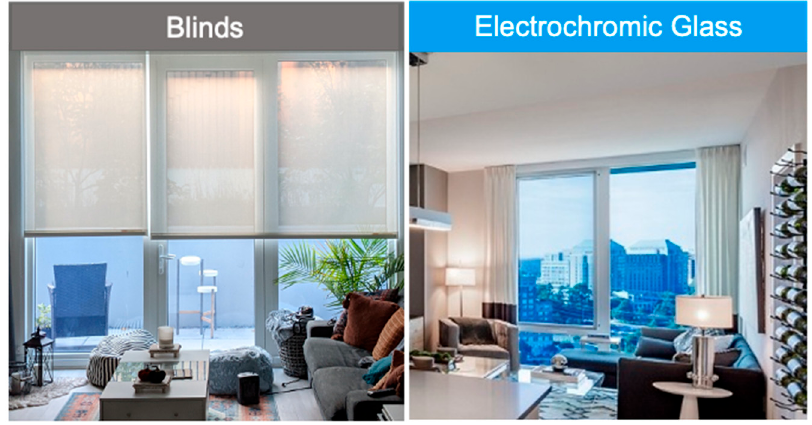
Figure 1. Representative images of the blinds and EC glass study conditions.